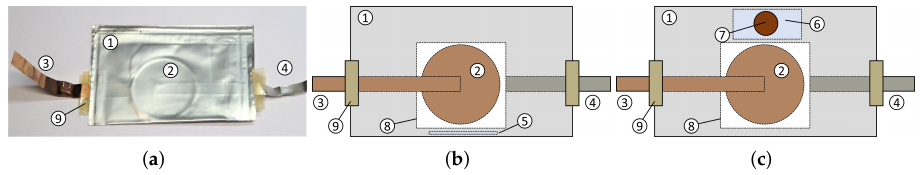
Figure 2. Assembled specimen ( a ) and principle sketches of specimen prepared for contamination with water ( b ) and oxygen ( c ). 1—pouch; 2—electrode stack; 3—negative copper tab; 4—positive aluminum tab; 5—glass container; 6—ZrO 2 plate; 7—self-healing injection port; 8—separator; 9—hot melt adhesive. ( a ) Specimen. ( b ) Water contamination. ( c ) Oxygen contamination.